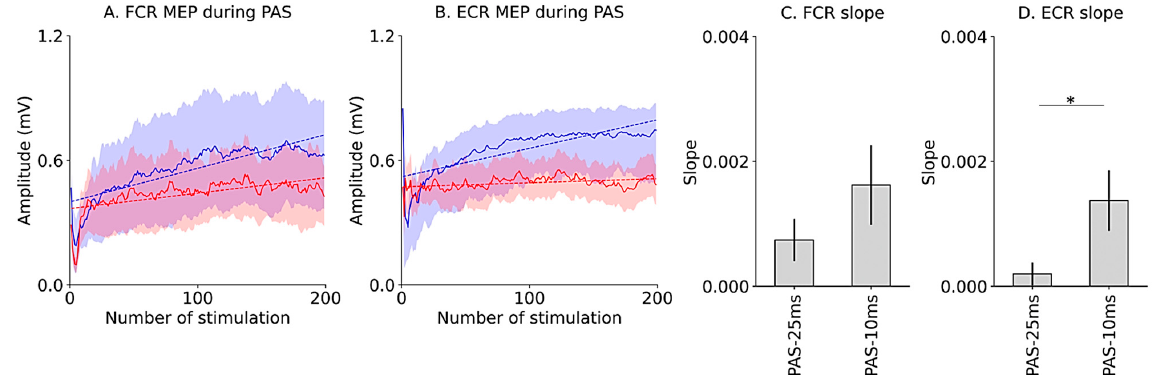
Figure 2. Grand-averaged time-series of the MEP amplitudes of FCR ( A ) and ECR ( B ) during PAS. The red and blue solid lines indicate the mean actual MEP amplitudes during PAS-25 ms and PAS-10 ms, respectively. The colored areas indicate the standard error of the mean. The red and blue dashed lines indicate the mean predicted MEP amplitudes during PAS-25 ms and PAS-10 ms by the linear regression model, respectively. The slopes of the MEP amplitudes for the FCR ( C ) and ECR ( D ) muscles during PAS. The slopes of MEP amplitudes for the ECR muscle were significantly steeper during PAS-10 ms than those during PAS-25 ms. MEP, motor evoked potential; FCR, flexor carpi radialis; ECR, extensor carpi radialis; PAS-25 ms, paired associative stimulation with a 25-ms interstimulus interval between peripheral electrical stimulation and TMS; PAS-10 ms, paired associative stimulation with a 10-ms interstimulus interval between peripheral electrical stimulation and TMS. *: p < 0.05.